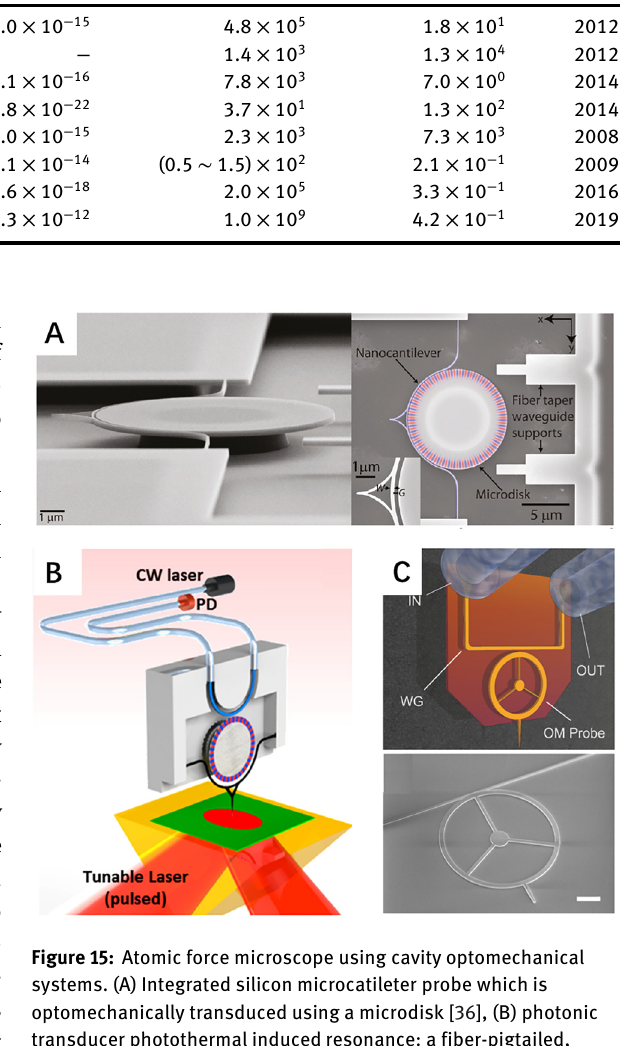
Table 2: Summary of sensitivities for force sensing experiments in optomechanical systems. Device type